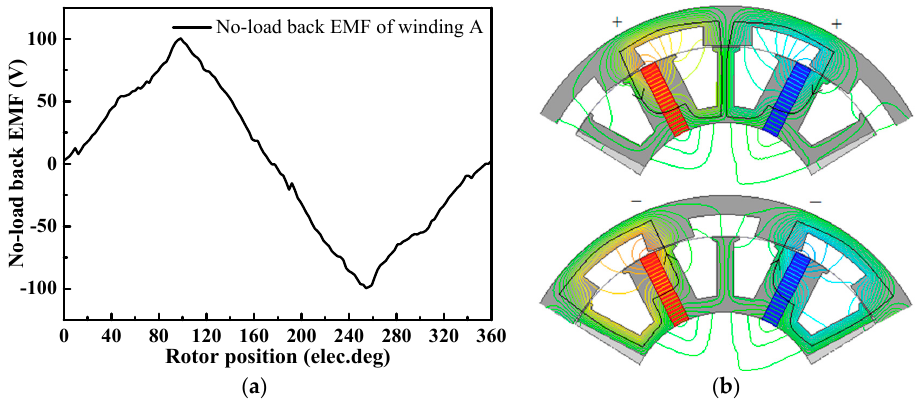
Figure 11. No-load back-EMF waveform and magnetic flux lines: ( a ) No-load back-EMF waveform of winding A; ( b ) Magnetic flux lines of module M A .